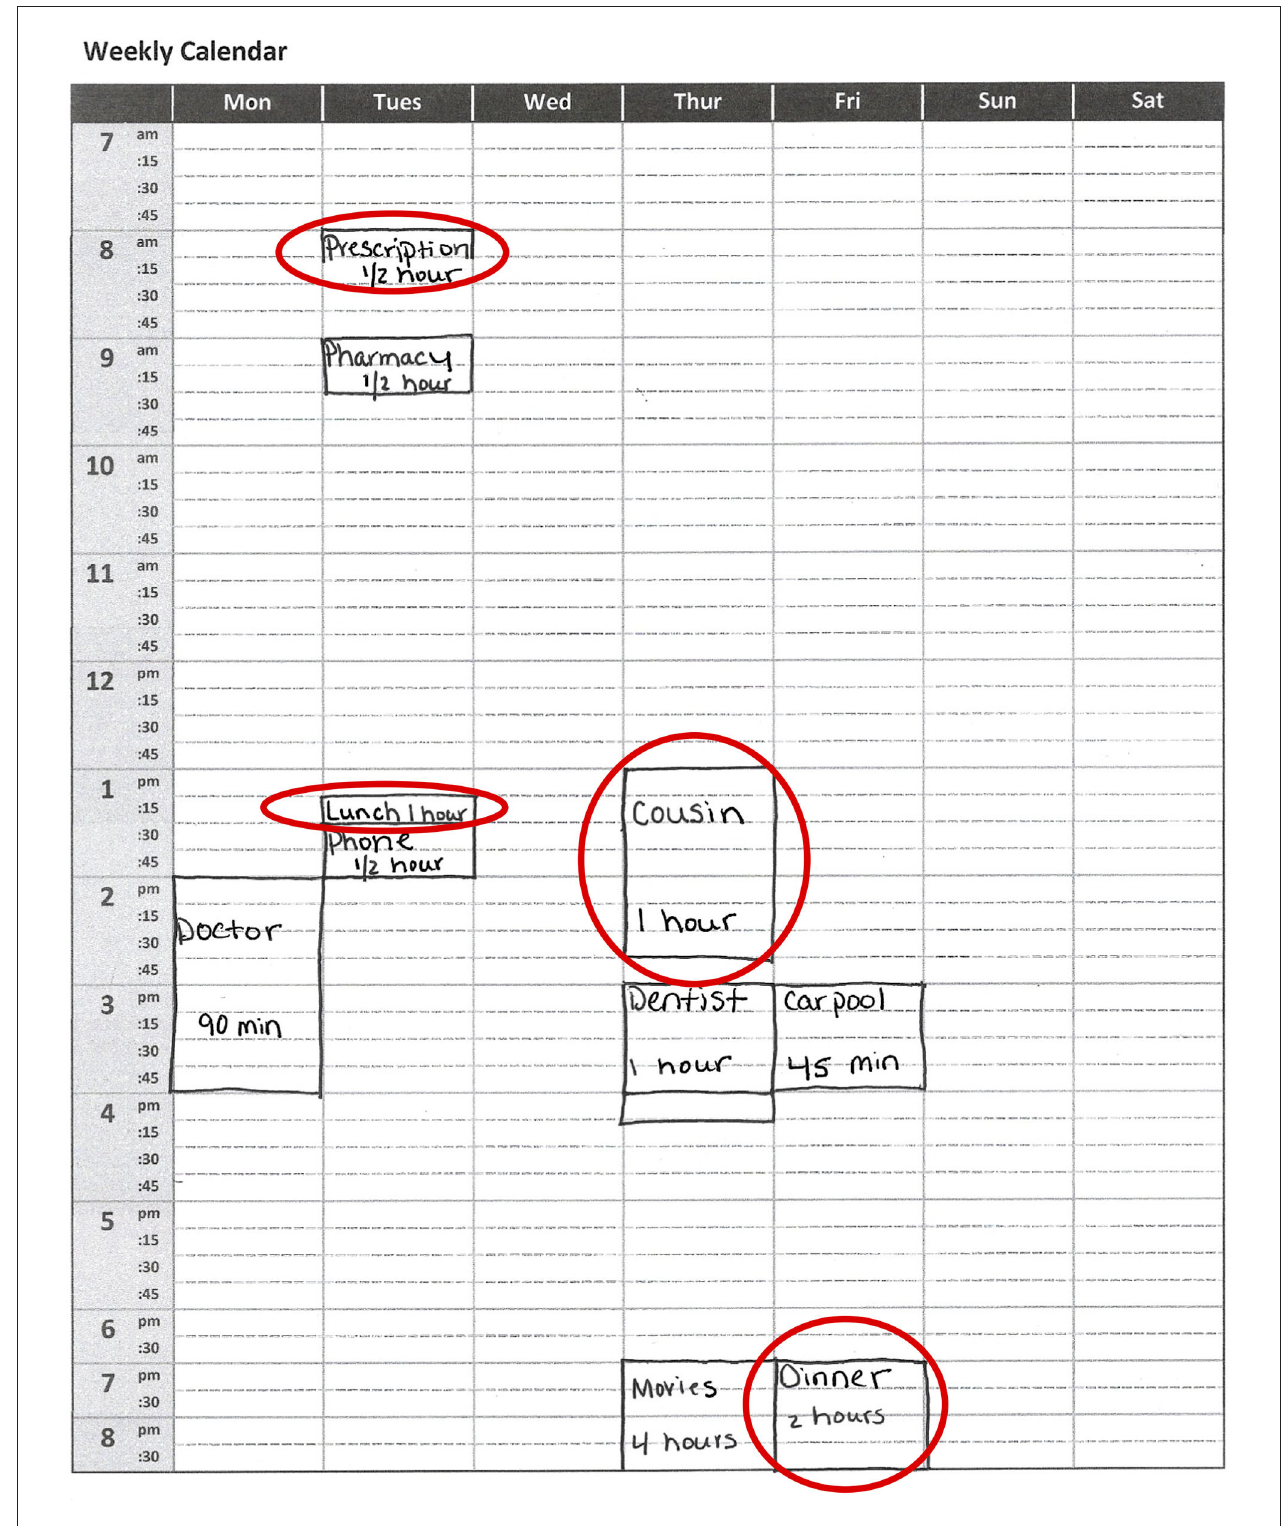
FIGURE 1 | Visual example of the weekly calendar stimulus on the Weekly Calendar Planning Activity. Patients are required to schedule appointments of specific lengths on specific days and times while following multiple rules. Red circles highlight errors, which can include placing the appointment on the wrong day or time (“Prescription ½ h”); marking the appointment with an incorrect duration (“Lunch 1 h”; “Cousin 1 h”); or having a vague description of the appointment (“Cousin,” “Dinner”).